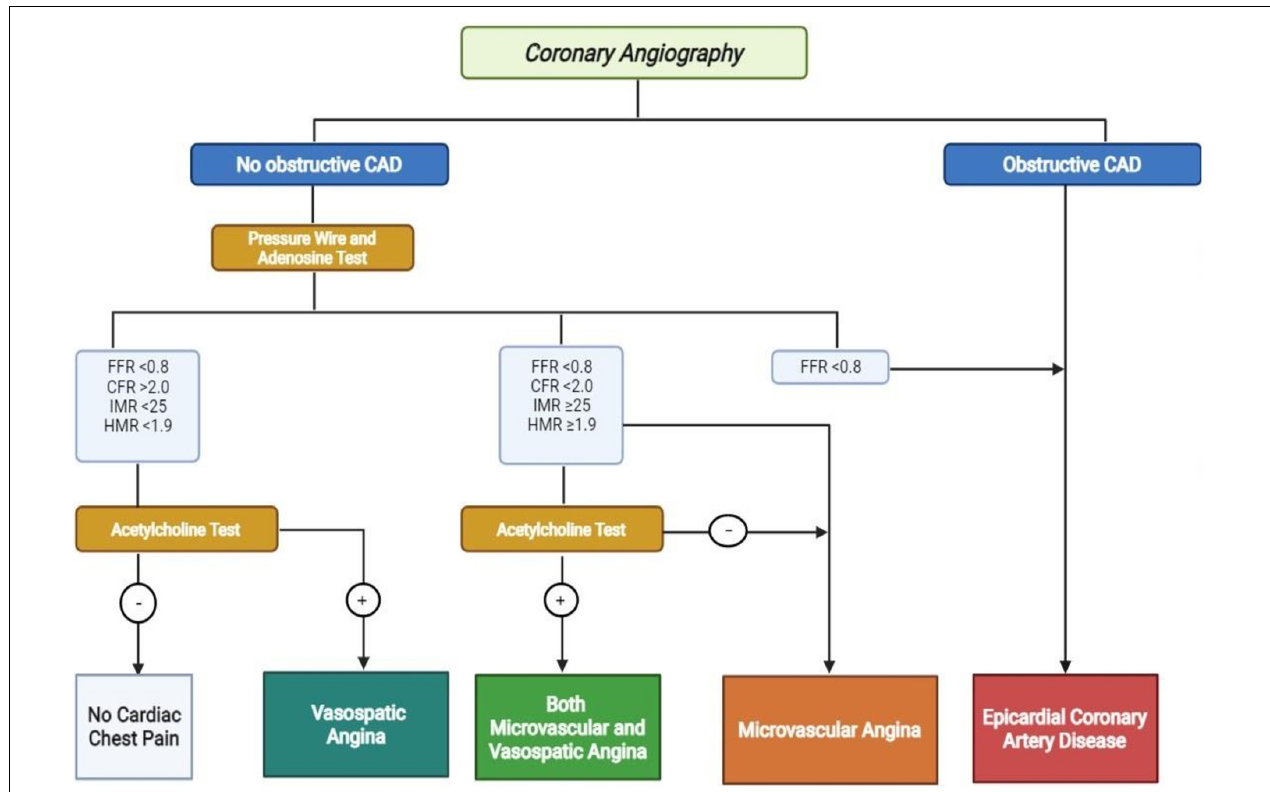
FIGURE 2 | Diagnostic algorithm for no obstructive and obstructive coronary artery disease. CAD, coronary artery disease; FFR, fractional flow reserve; CFR, coronary flow reserve; IMR, index of microvascular resistance; hyperemic microvascular resistance. Positive Acetylcholine Test: > 90% reduction in epicardial coronary artery with angina and ECG